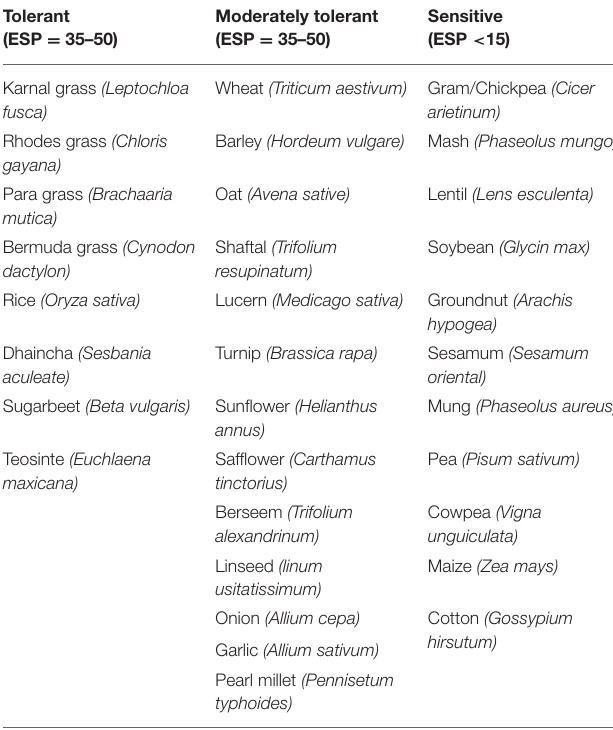
TABLE 7 | Relative tolerance of some crops to soil sodicity